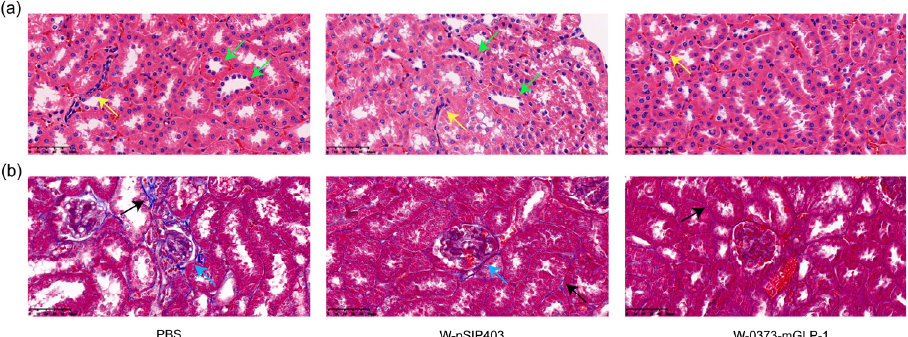
Figure 9. The protection e ff ects of 14-day W-0373-mGLP-1 administration on kidney. Scale bar 10 µm (40× magni fi cation). ( a ) H&E staining of kidney in db/db mice. Yellow arrow: in fl ammatory cells in fi ltration; green arrow: thickening of the renal tubules basement membrane; ( b ) Masson staining of kidney. Blue arrow: vacuoloid changes in tubular epithelial cells; black arrow: intersti- tial fi brosis.